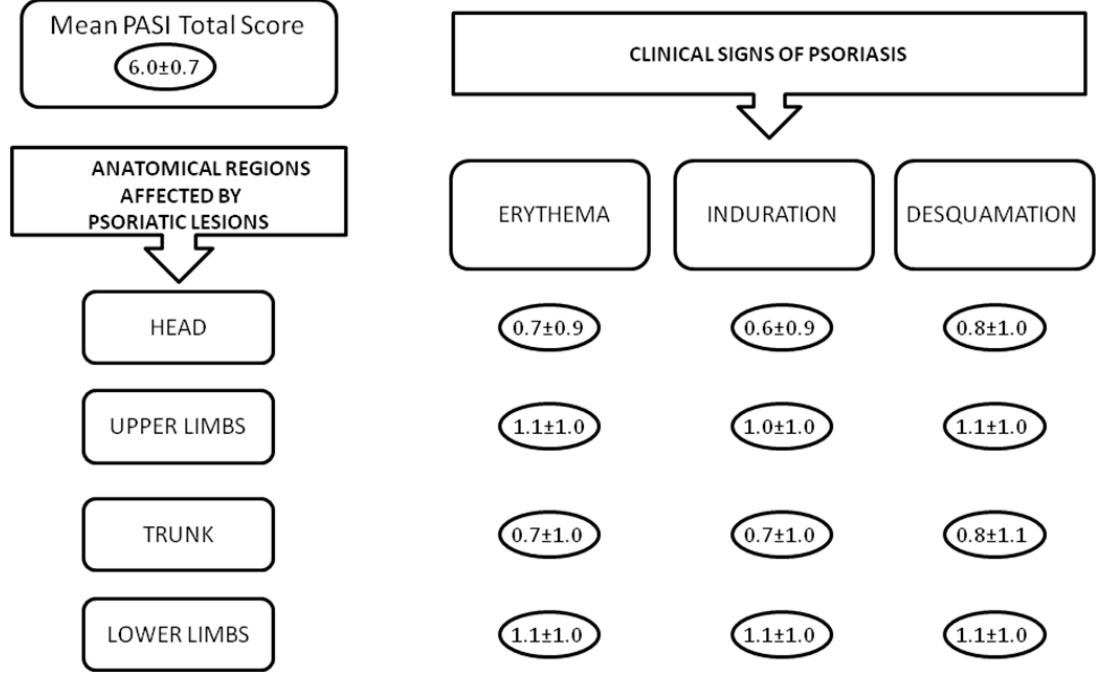
Figure 1. Psoriasis Area Severity Index (PASI) score. The figure shows the mean values of the PASI total score as well as its single